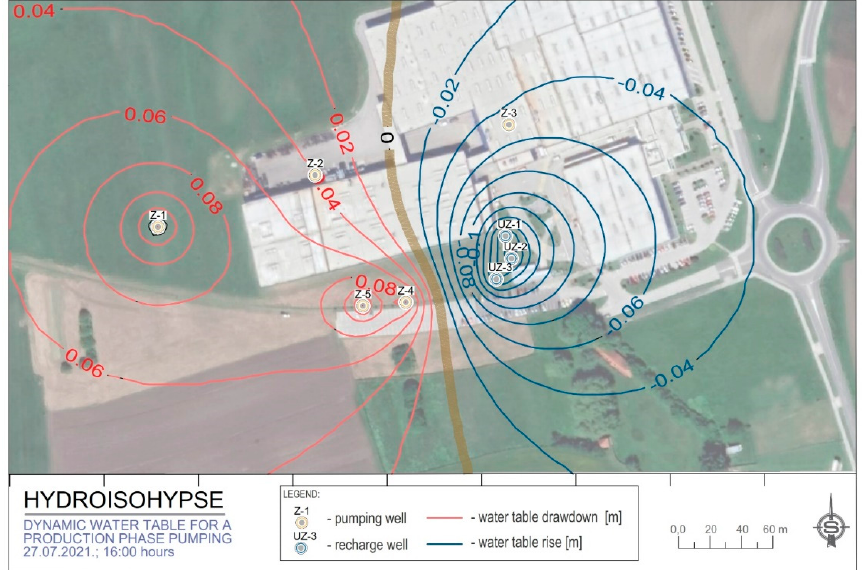
Figure 27. Hydroisohypses of relative drawdown/build-up of the water surface for the dynamic state of water pumping and discharging on 27 July 2021 at 16:00.